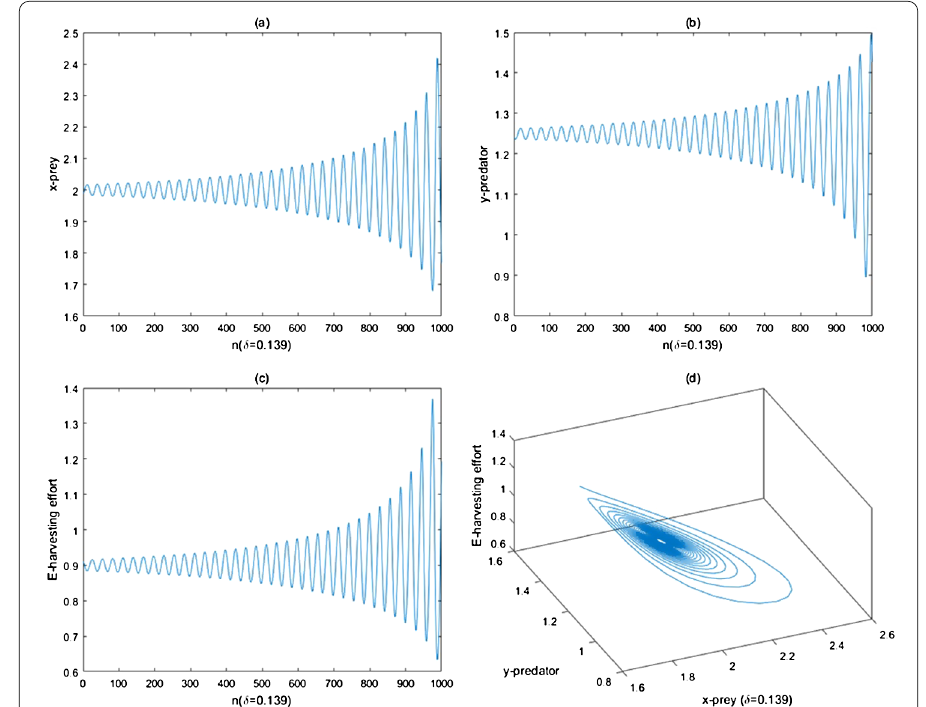
Figure 1 δ = δ 1 + 0.014, the fixed point (2,1.25,0.9) is an unstable